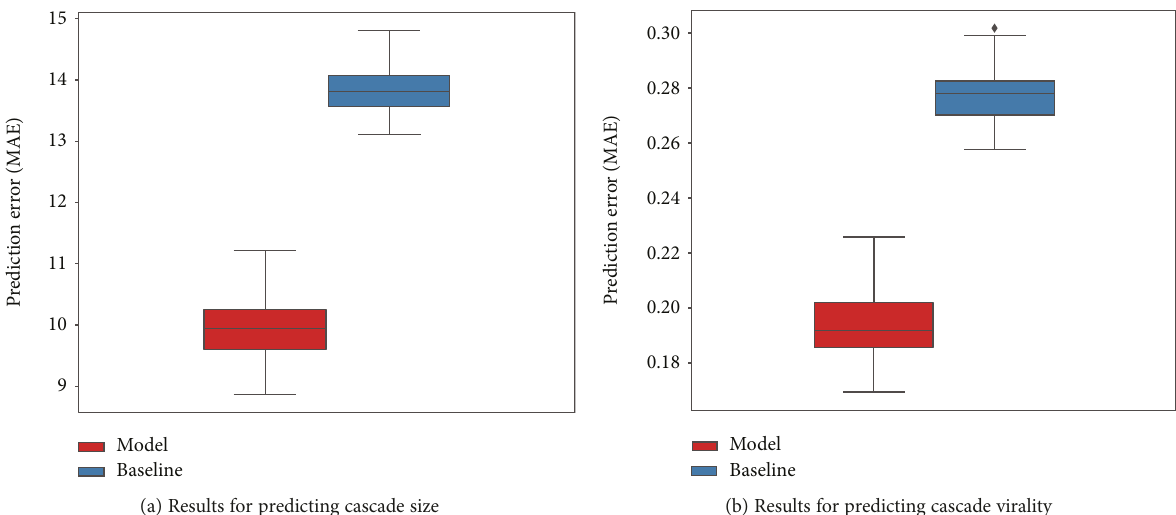
Figure 8: The fi gure shows the prediction performance results for 100 runs for the prediction of cascade size (a) and cascade virality (b). The fi gure compares the results of the GBR prediction algorithm and the results obtained from a baseline